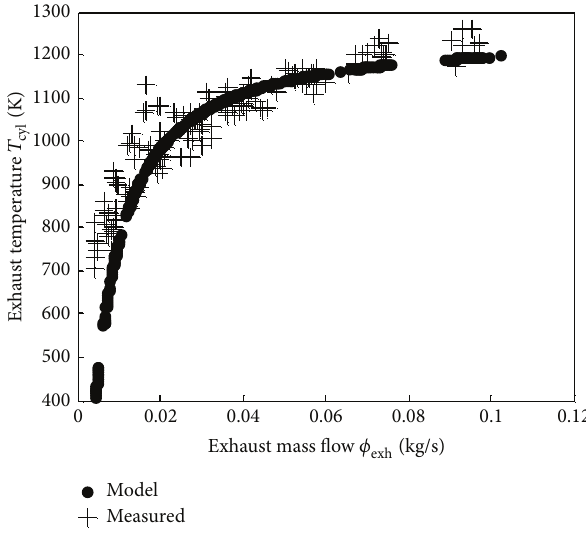
Figure 16: Model of the temperature at the turbine inlet.